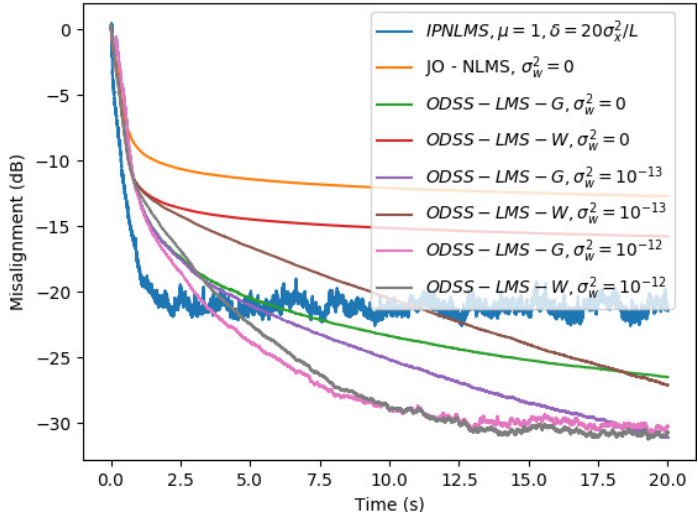
Figure 5. Normalized misalignment of the IPNLMS, JO-NLMS, ODSS-LMS-G, and ODSS-LMS-W algorithms for different values of σ 2 w . The input signal is an AR(1) process, with β = 0.9, L = 512, and SNR = 20 dB. The unknown system is the acoustic echo